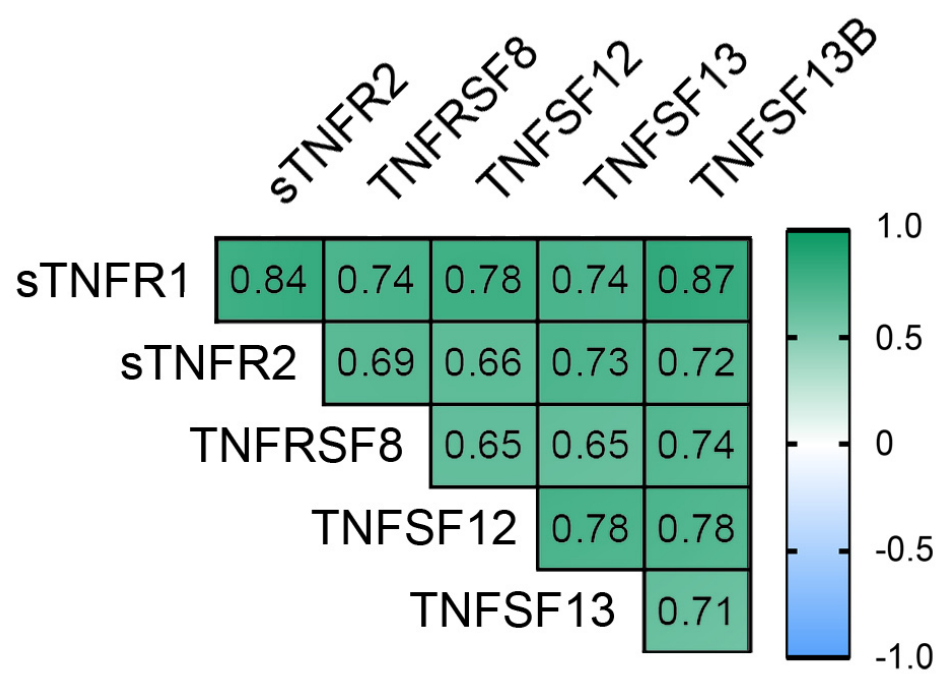
Figure 3. Correlation relationships between sTNF-R1, sTNFRSF8, and ligands—TNFSF12, TNFSF13, TNFSF13B. Filled squares show significance ( p < 0.05).